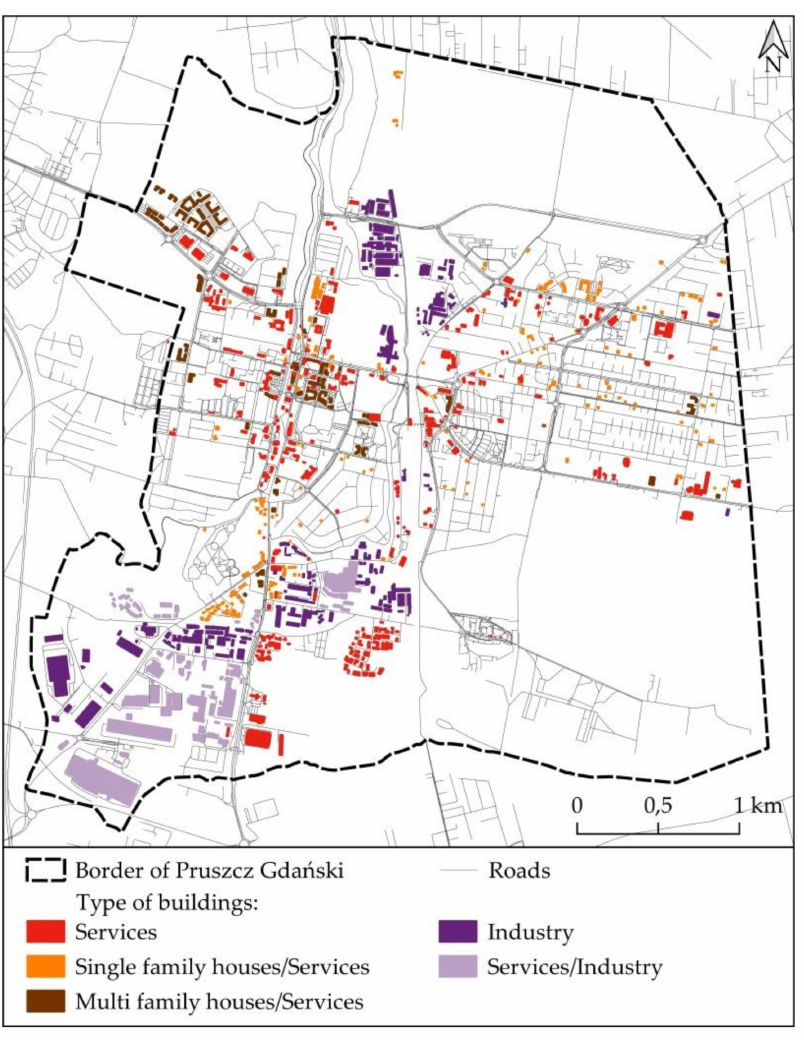
Figure 5. Industrial buildings and service development in Pruszcz Gda´nski by type in 2020 (source: own elaboration based on [27,28]).